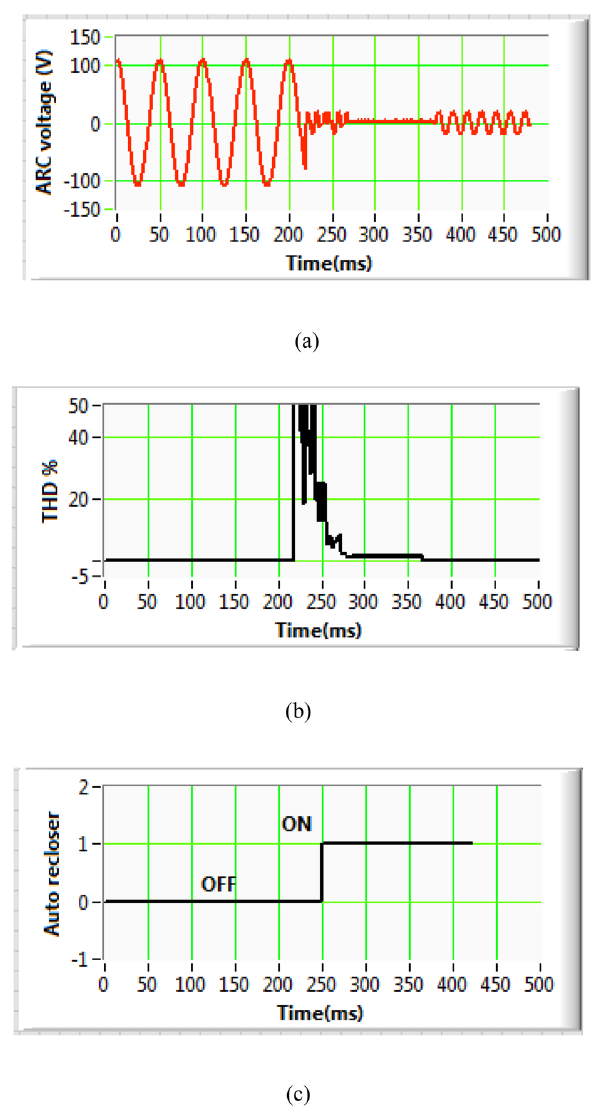
Fig. 11 Single pole to ground fault a Arc voltage b Total harmonic distortion during pre-fault, fault, secondary arc and post-fault val- ues c recloser